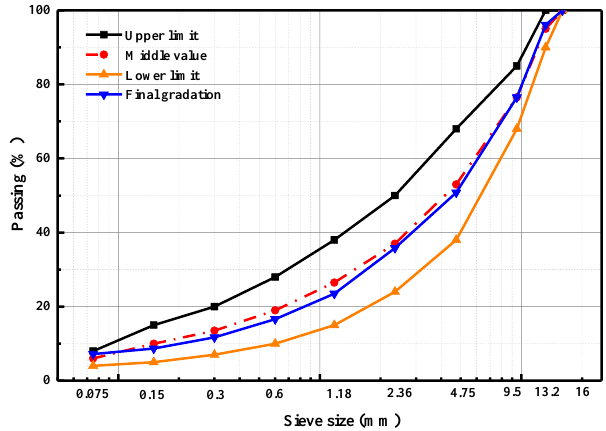
Figure 4. Determination of aggregate gradation for asphalt